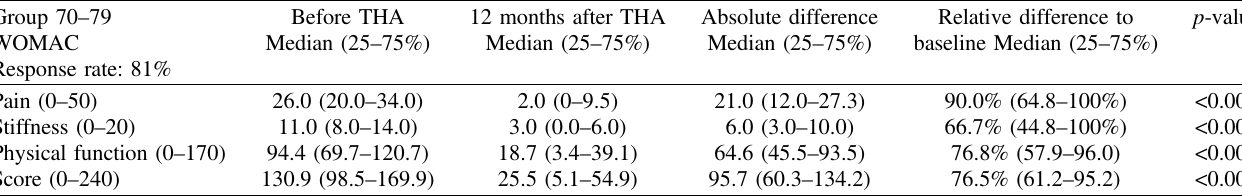
Table 5. WOMAC score and items before and after THA in the group 70 – 79.